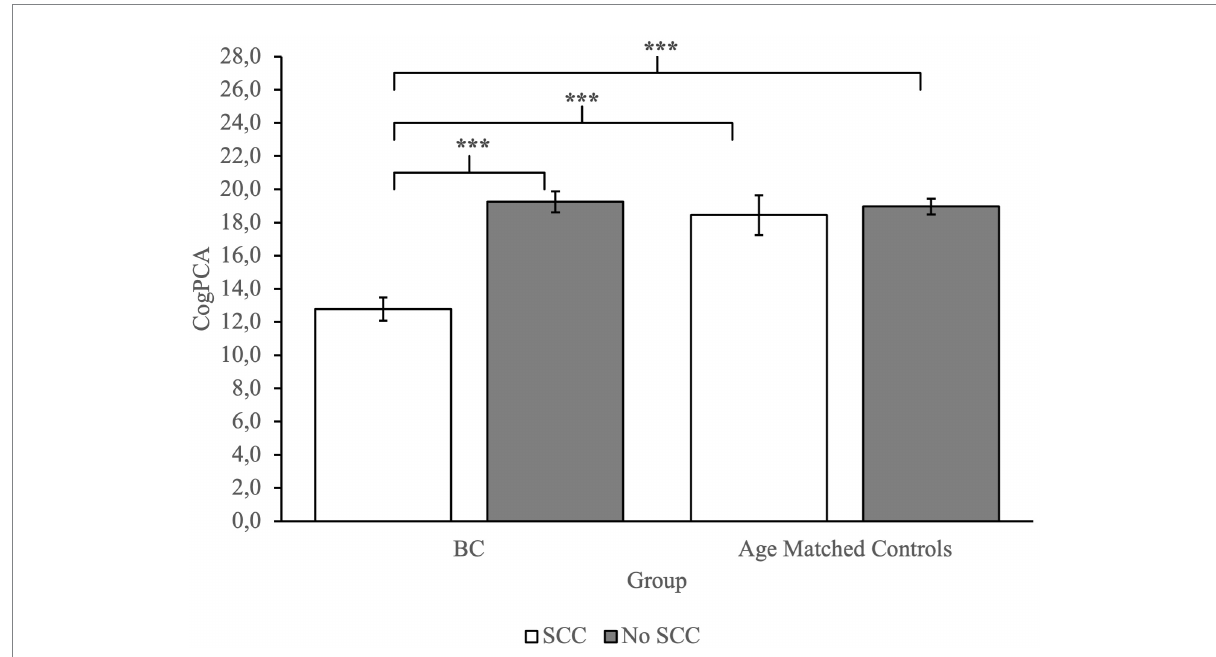
FIGURE 2 Group comparison between FACTCog Perceived Cognitive Abilities (PCA) measures: BC patients reporting SCC describe themselves as less cognitive skilled compared to BC patients not referring SCC and age-matched controls. *** p <